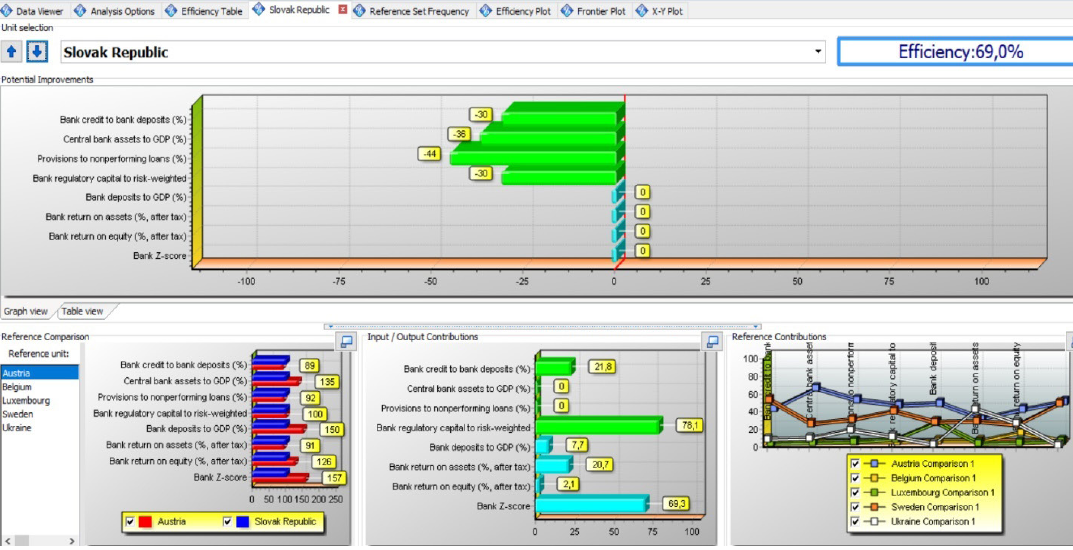
Figure C2. Analysis of the results and potential for improving the efficiency of the banking system of the Slovak Republic as of 2020 for the BCC